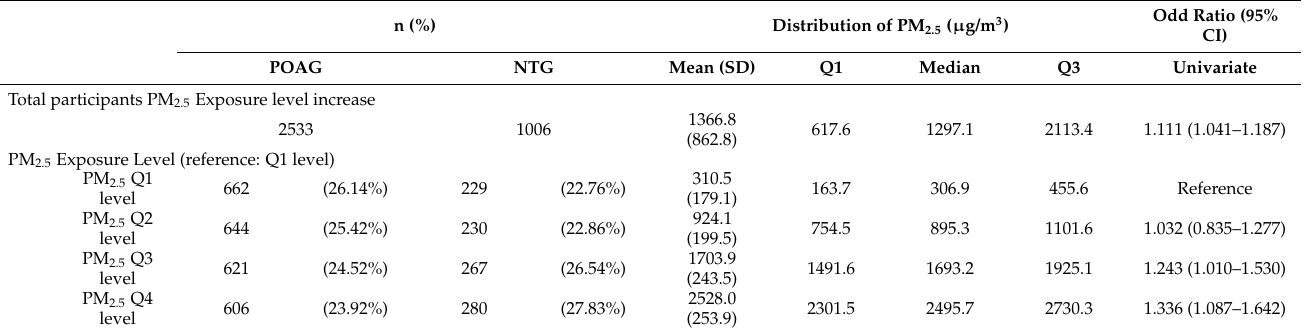
Table 2. Logistic regression analysis of particulate matter (PM)2.5 level between NTG and POAG.